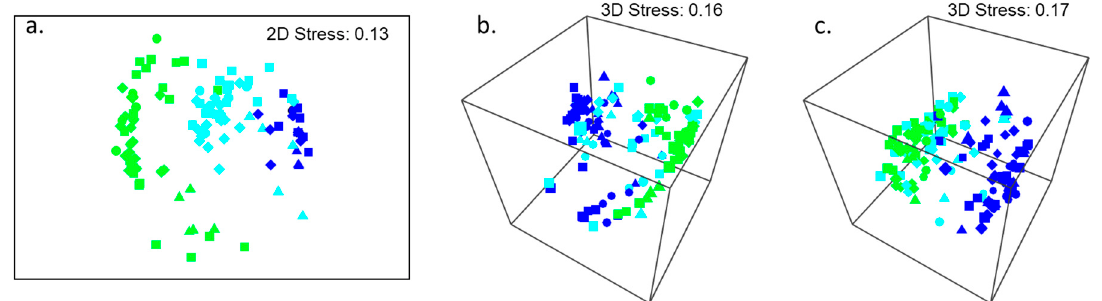
Figure 2. Non-metric multidimensional scaling (nMDS) plots of ( a ) primary cover, ( b ) understorey cover and ( c ) mobile invertebrates assemblages associated with different natural levels of Hormosira cover prior to manipulation (full cover = dark blue, patchy cover = aqua, negligible cover = green) at each of four sites (13th Beach = triangles, Bridgewater Bay = circles, Point Roadknight = squares, Sorrento = diamonds). All data were fourth-root transformed. 3D nMDS plots are shown where stress exceeded 0.20 for 2D plots.